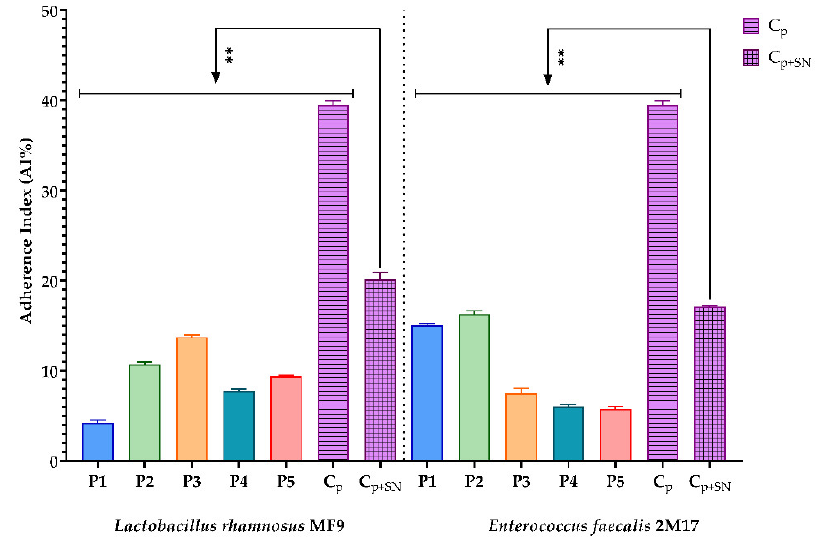
Figure 7. Graphic representation of AI% values representing the synergic influence of BPE and probiotic Soluble Compounds (SN) on the adherence capacity of Enterobacter cloacae ; (P1–P5)-BPE samples, pathogenic strains adherence control (Cp), pathogenic strains with probiotic supernatant adherence control (C P+SN ). The differences between the effects of BPE and soluble compounds of strains on adherence capacity of clinical strains were statistically analysed using one-way ANOVA, followed by Dunnett’s test for multiple comparisons of groups. (** p < 0.01).